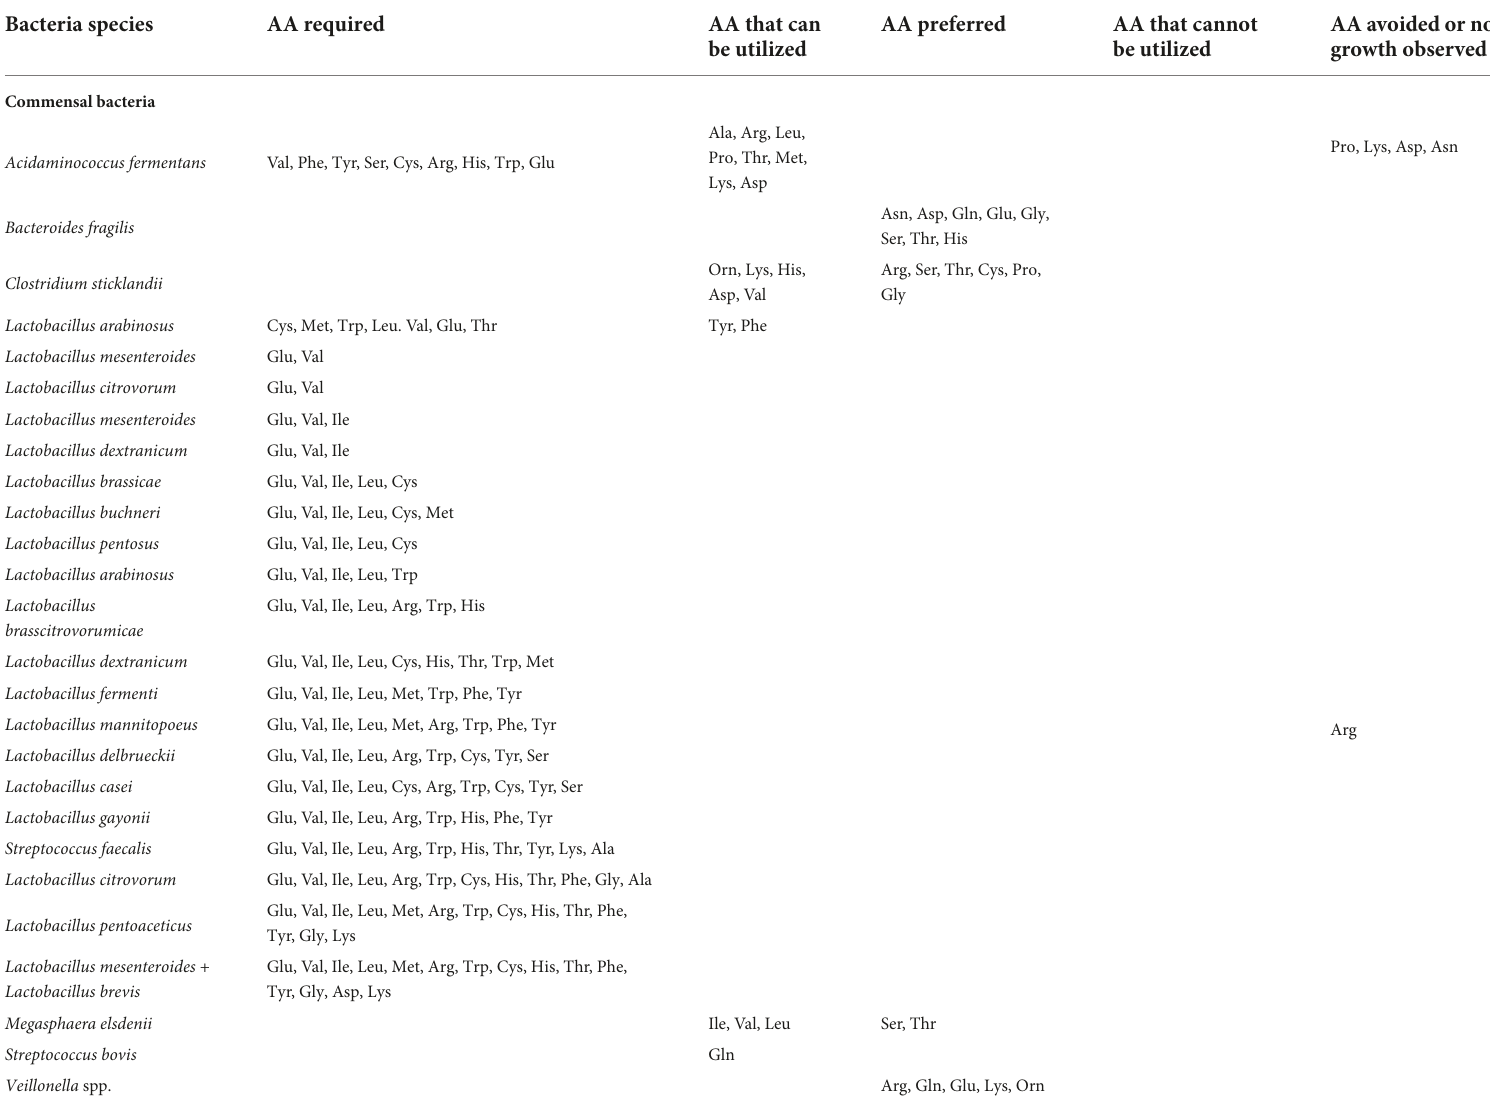
TABLE 1 AA required, utilized, preferred, or avoided according to bacterial